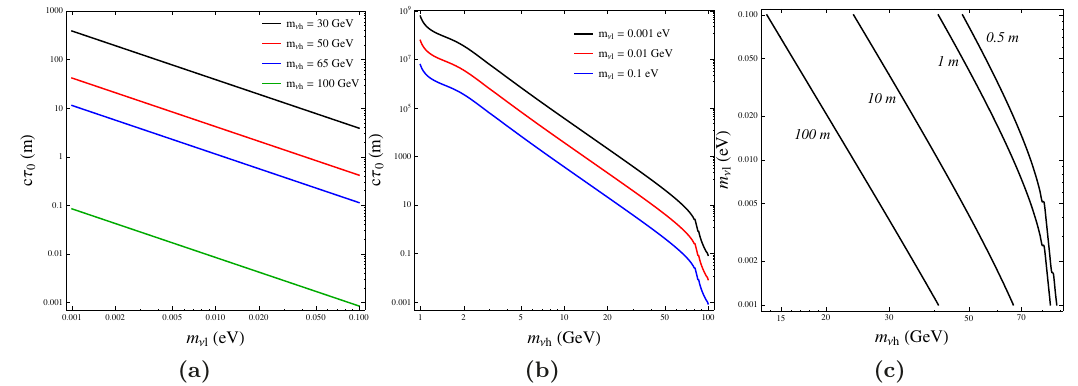
. (c) Contour lines of the heavy neutrino decay h , m ν ). h l